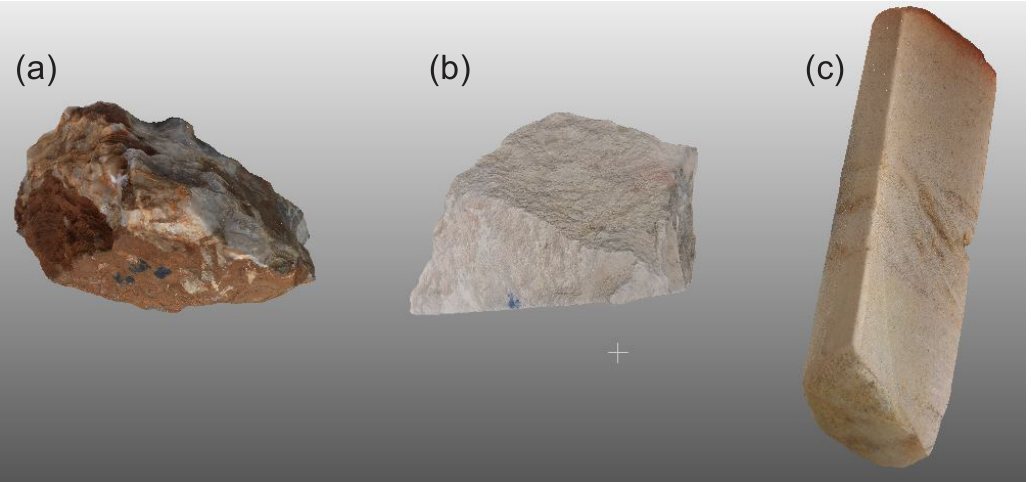
Figure 14. Reconstructed samples using the proposed methodological procedures visualized in CloudCompare [52]. ( a ) Sample 1, ( b ) Sample 2 and ( c ) Sample 3.